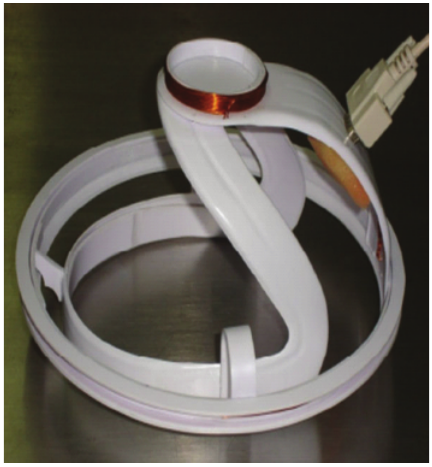
Figure 1: Brain injury detector based on Volumetric Electromag- netic Phase Shift Spectroscopy. Courtesy of UC Berkeley.